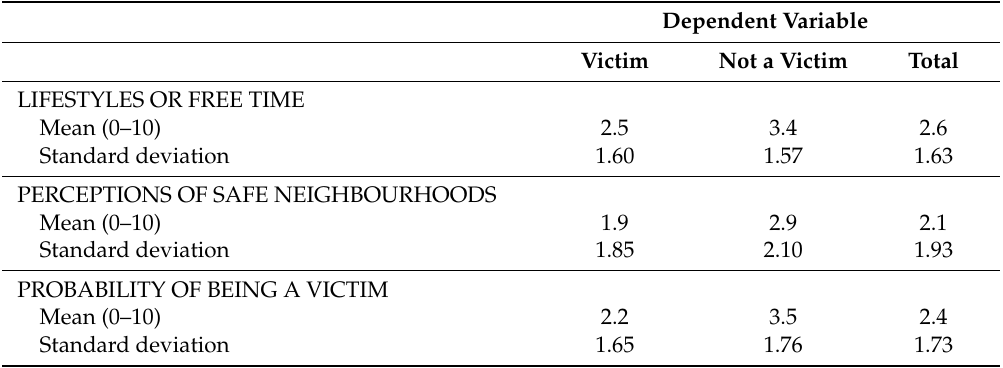
Table 4. Description of psychosocial variables by the dependent variable, “having been a victim or not” in the last 12 months (Spain, 2016).